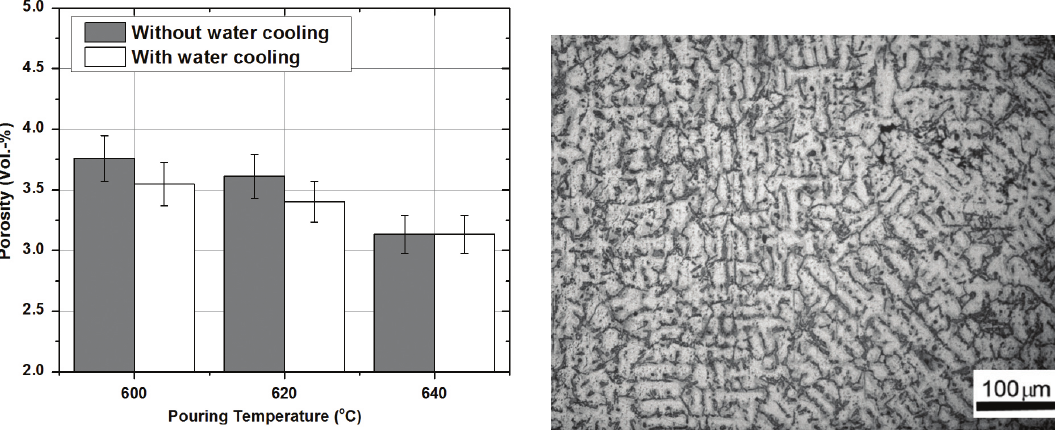
Figure 6. Microstructures of the conventionally cast A319 Al-Si alloy.